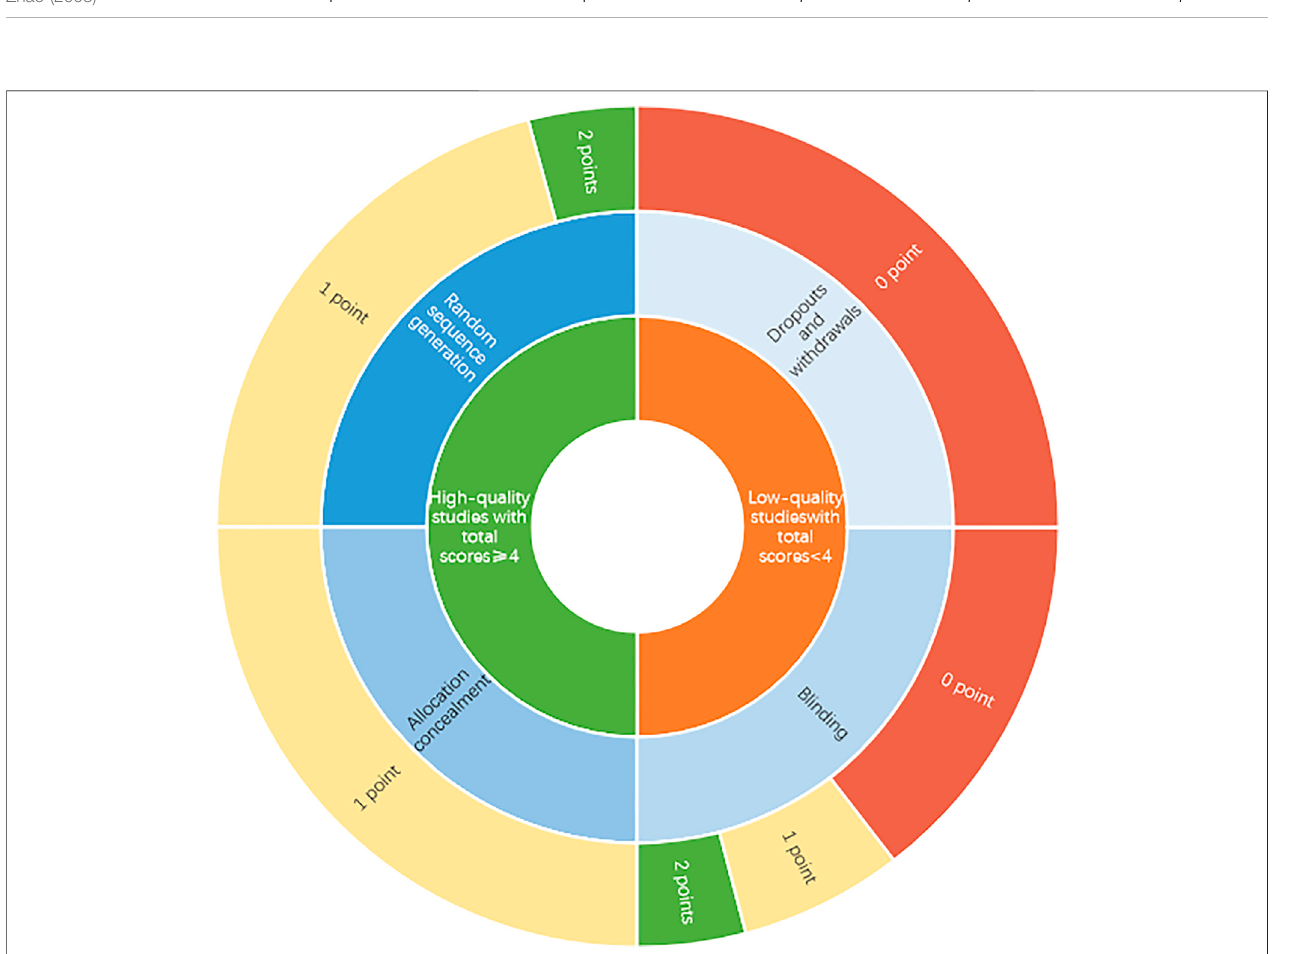
FIGURE 2 | Risk of bias sunburst